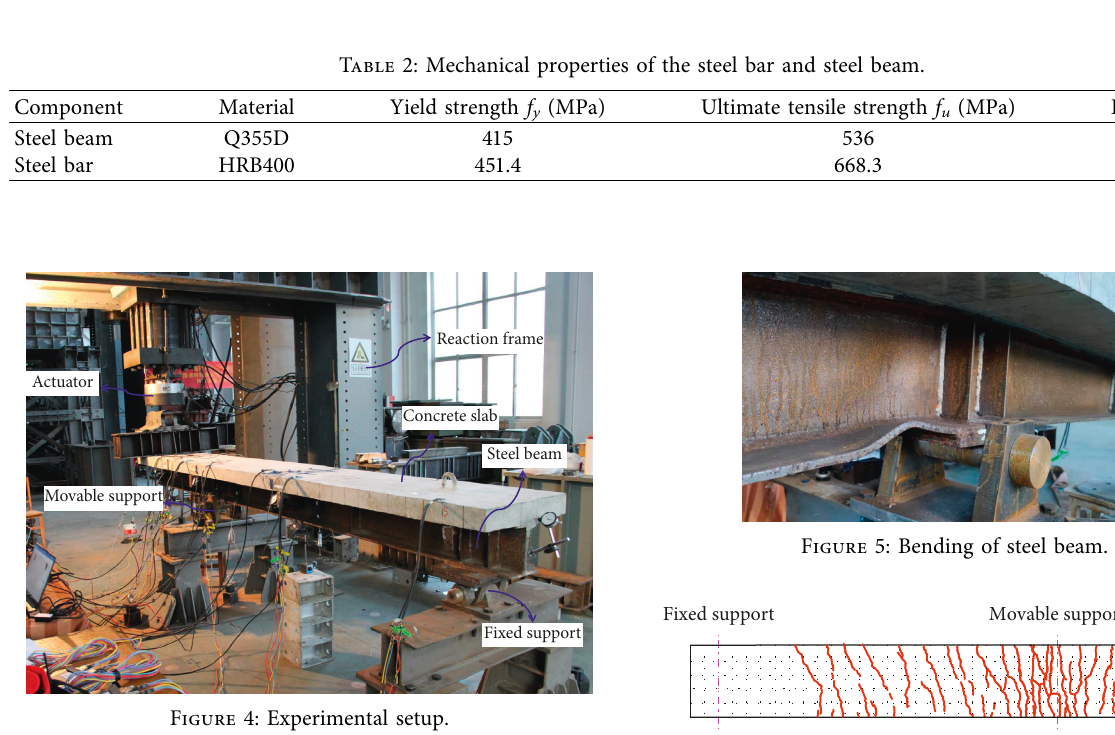
Figure 6: Crack distribution in test